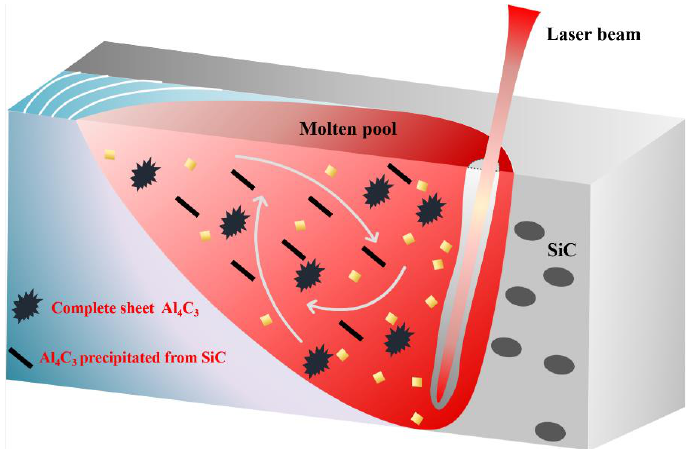
Figure 9. The schematic diagram of two Al 4 C 3 in laser welded 20 vol% SiCp/2A14 composites.